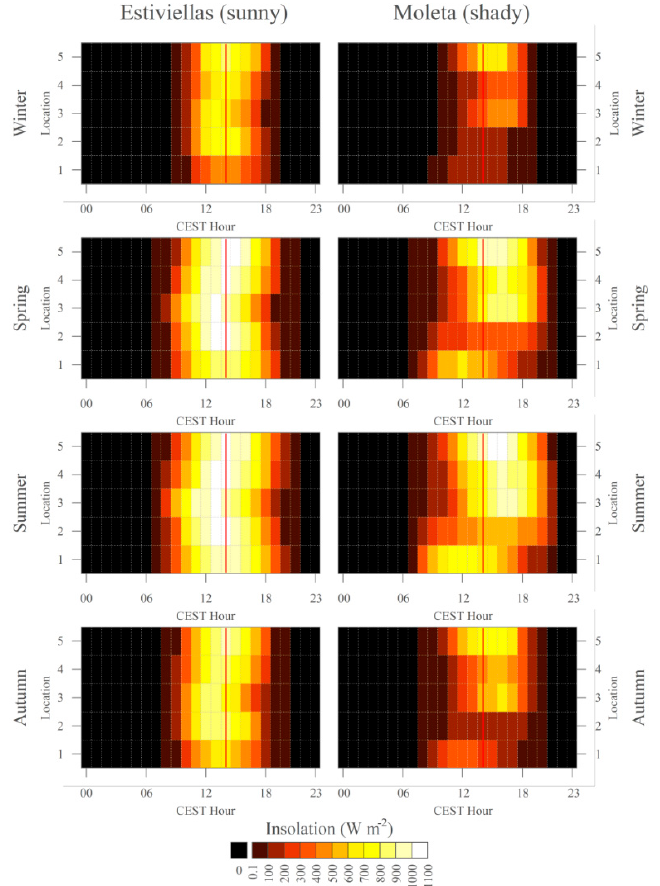
Figure 2. Mean seasonal estimated hourly insolation in the ten monitored locations of the Estiviellas and Moleta slopes. Black represents null insolation (night), and red to white ramp color represents intensity (in W m 2 ). Red lines represent the solar noon (at 14 h UTC + 2, local time).